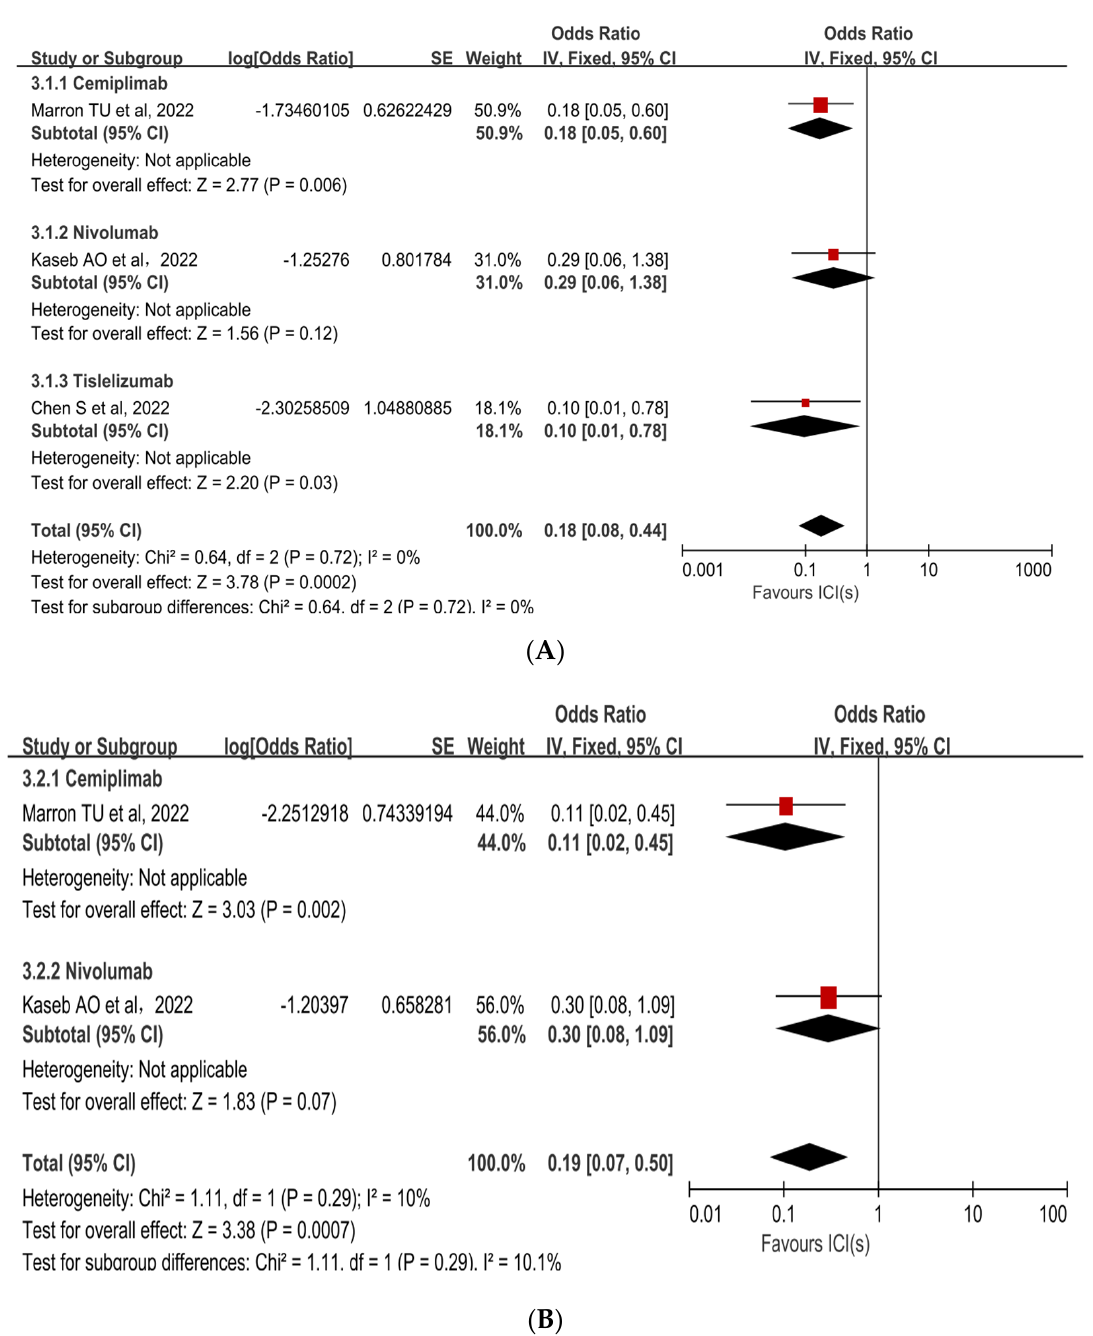
Figure 4. Subgroup analysis of immune checkpoint inhibitor drug types for ( A ) pCR and ( B ) Grade 3−4 TRAEs. ICI: immune checkpoint inhibitor; pCR: pathological complete response; TRAEs: treatment-related adverse events [33,35,36].